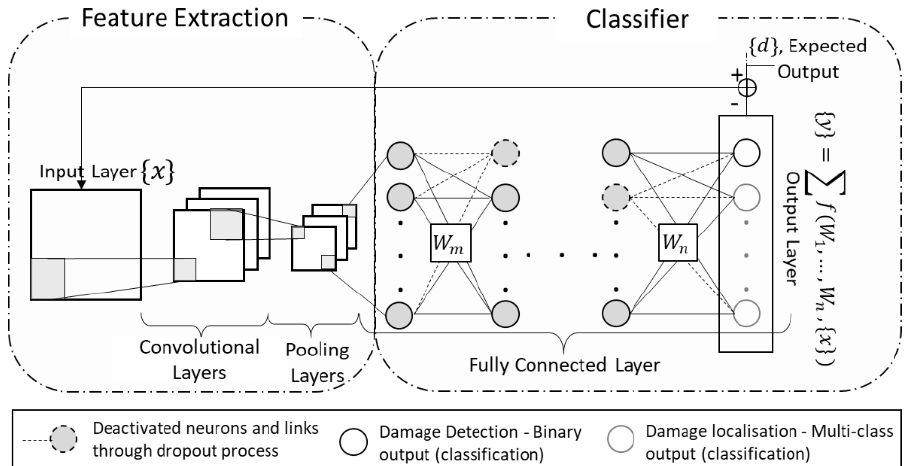
Figure 6. Schematic demonstration of a typical CNN architecture.